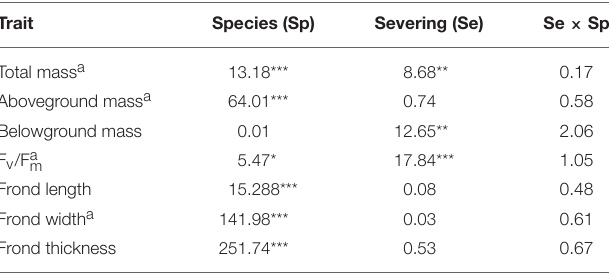
TABLE 2 | Individual experiment results of a two-way ANOVA for effects of species and rhizome severing on biomass, F v /F m , and frond morphology. Trait Species (Sp) Severing (Se) Se × Sp Total mass a